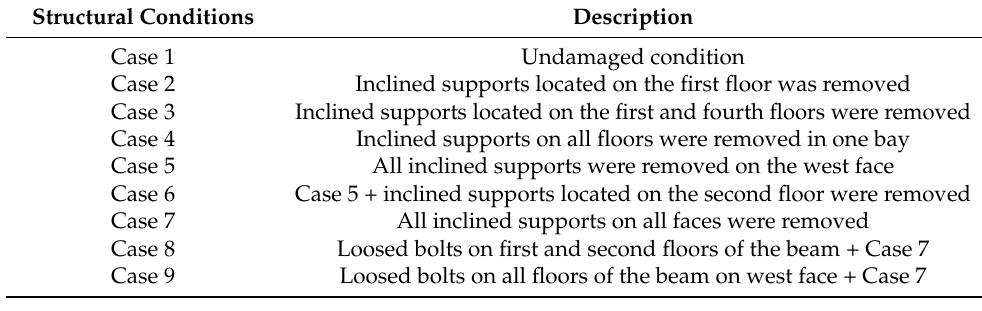
Table 7. Description of the structural cases for the benchmark [30].